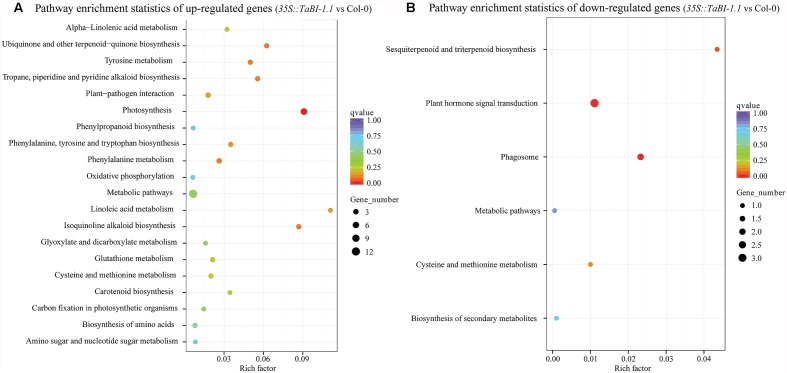
KEGG enrichment analysis of differentially expressed genes between 35S::TaBI-1.1 and Col-0. The pathway enrichment statistics of up-regulated genes (A) and down-regulated genes (B) in 35S::TaBI-1.1 vs. Col-0. Vertical coordinates represent enriched pathways, and horizontal coordinates represent enrichment factors. The size of each point represents the number of differentially expressed genes in the pathway, and the color of the point represents the q-value.